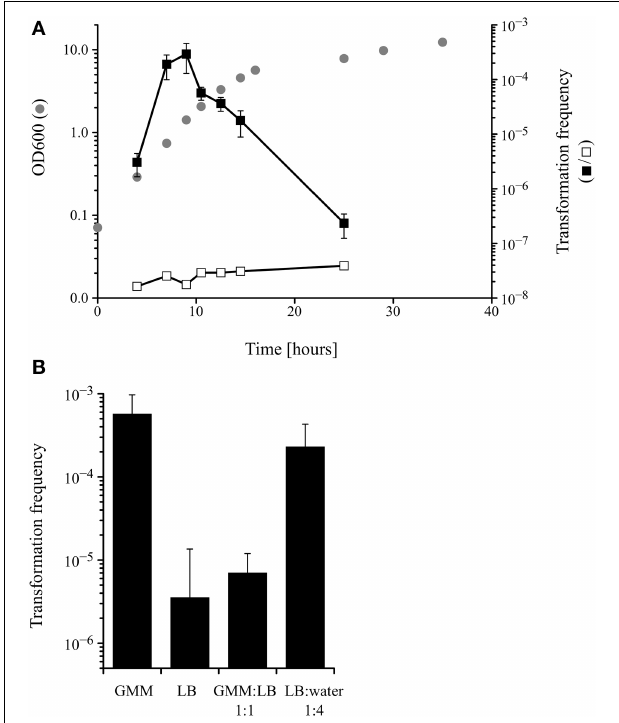
FIGURE 1 | (A) Kinetics of competence development during growth of M. luteus trpE16 in glutamate minimal medium (GMM) at 30 ◦ C. Optical density (gray circles), transformation frequency (black squares) and the frequency of spontaneous reversion of the trpE16 strain to Trp + (white squares) were measured at the indicated time points. (B) Effect of growth medium on the transformation frequency of M. luteus trpE16. The cells of one culture grown in complex medium were split in the respective media at cell density of 10 8 × ml − 1 and incubated for 16h before determining the transformation frequency. The mean values and standard deviation of three (in A ) and four (in B ) independent experiments are shown. GMM, glutamate minimal medium; LB, lysogeny broth